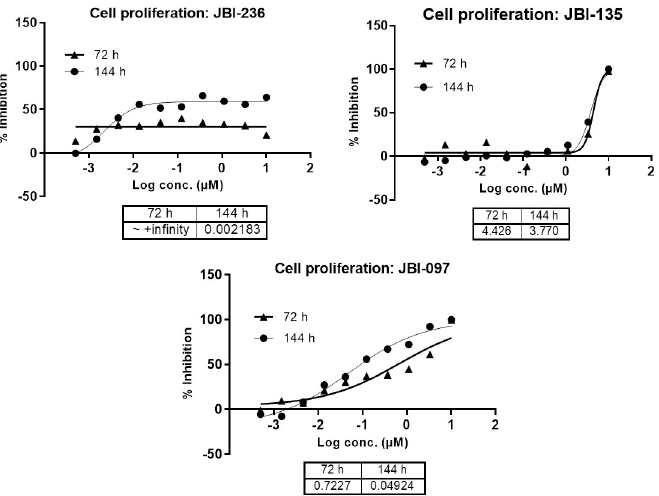
Fig 2. Anti-proliferative activity of JBI-097 in human erythroleukemia HEL 92.1.7 cells. Cell proliferation was evaluated using a Alamar Blue assay. Human cell lines (HEL 92.1.7; density, 5 and 10 × 10 3 for 3 days and 6 days; respectively) were incubated with or without the indicated concentrations of JBI-097, Ricolinostat and Iadademstat for 72 and 144 h. The results shown are representative from two independent